Question: Draft a figure caption describing what is shown.
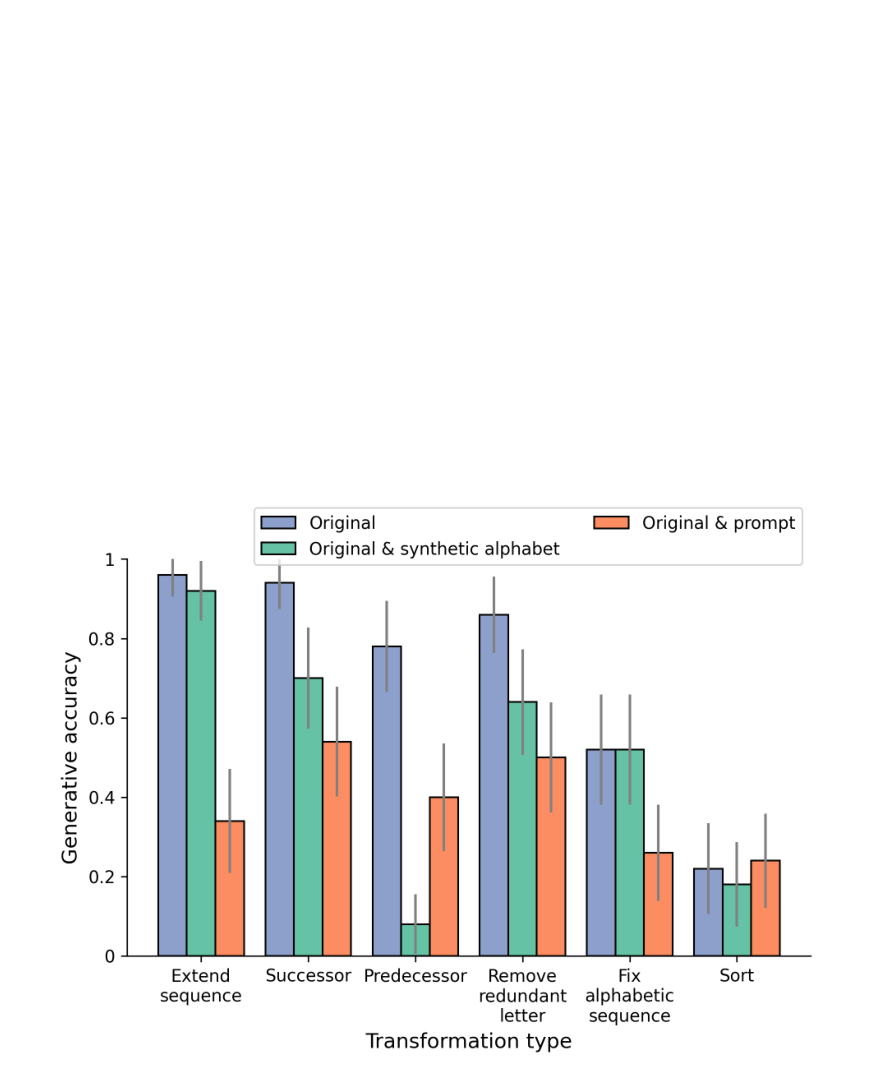
Answer: Counterfactual comprehension check. Comparison of GPT-3 performance on zero-generalization letter string problems between original tasks (blue) and the only marginally modified tasks involving a synthetic alphabet without modification of the interval size (green) and a modified prompt without modified string sequence (orange). The accuracy on modified tasks is lower than on the original ones but, greater than 0.2 except for ‘remove redundant letter’ and ‘sort’ involving the synthetic alphabet. The figure and the order of the transformation types correspond to Figure 6b in the original paper. These results reflect an average performance for N=50 instances.